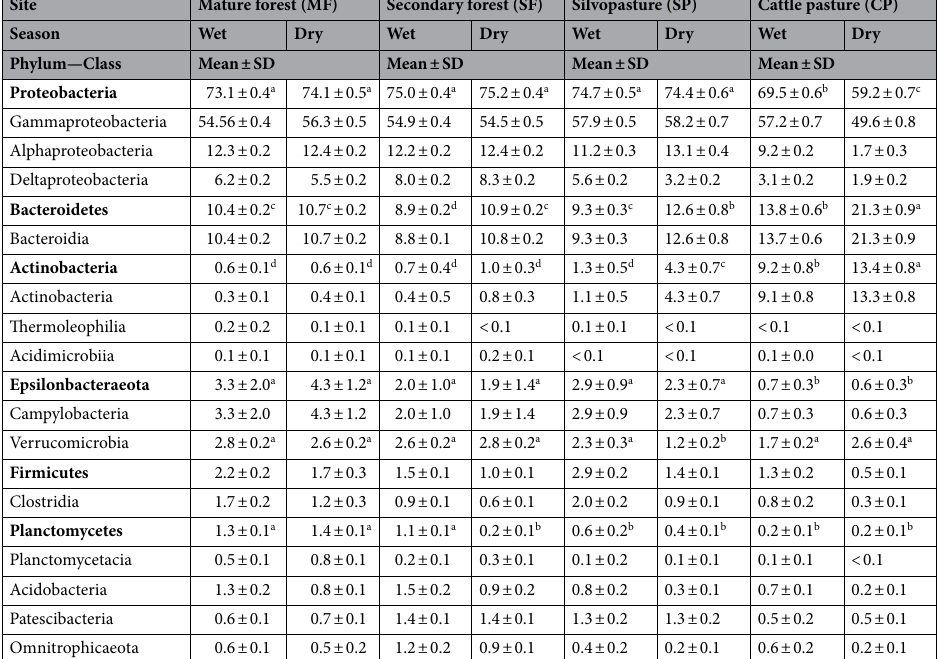
Table 1. Seasonal mean relative abundance ± standard deviation of bacterial phyla (> 1% of all ASVs) found in samples from the four streams surrounded by different land uses that were sampled in this study. Within each row, letters indicate significant differences between land uses ( p < 0.05) based on Kruskal–Wallis and pairwise Wilcox (with Benjamini–Hochberg correction)